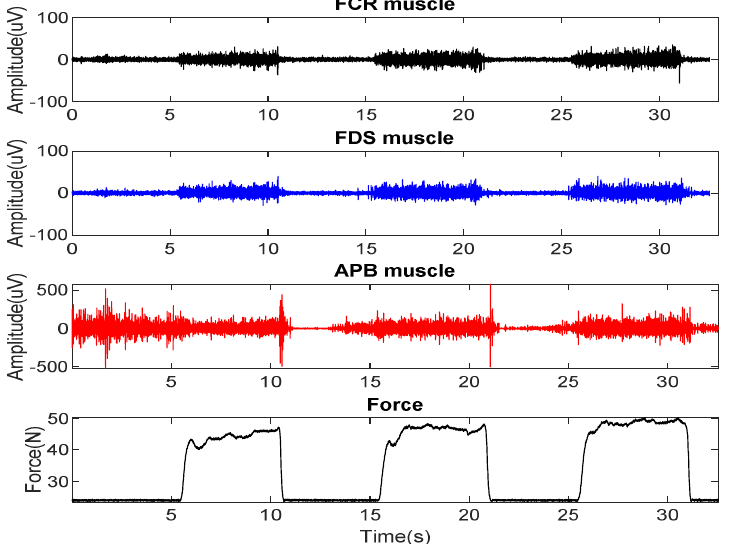
Fig. 5. A plot of the EMG for the tripod grip with 30% MVC for participant 2 (male participant). The top 3 figures represent the 3 trials of EMG from the FCR, FDS and APB, respectively. The bottom figure is the force signal measured in Newton with hand